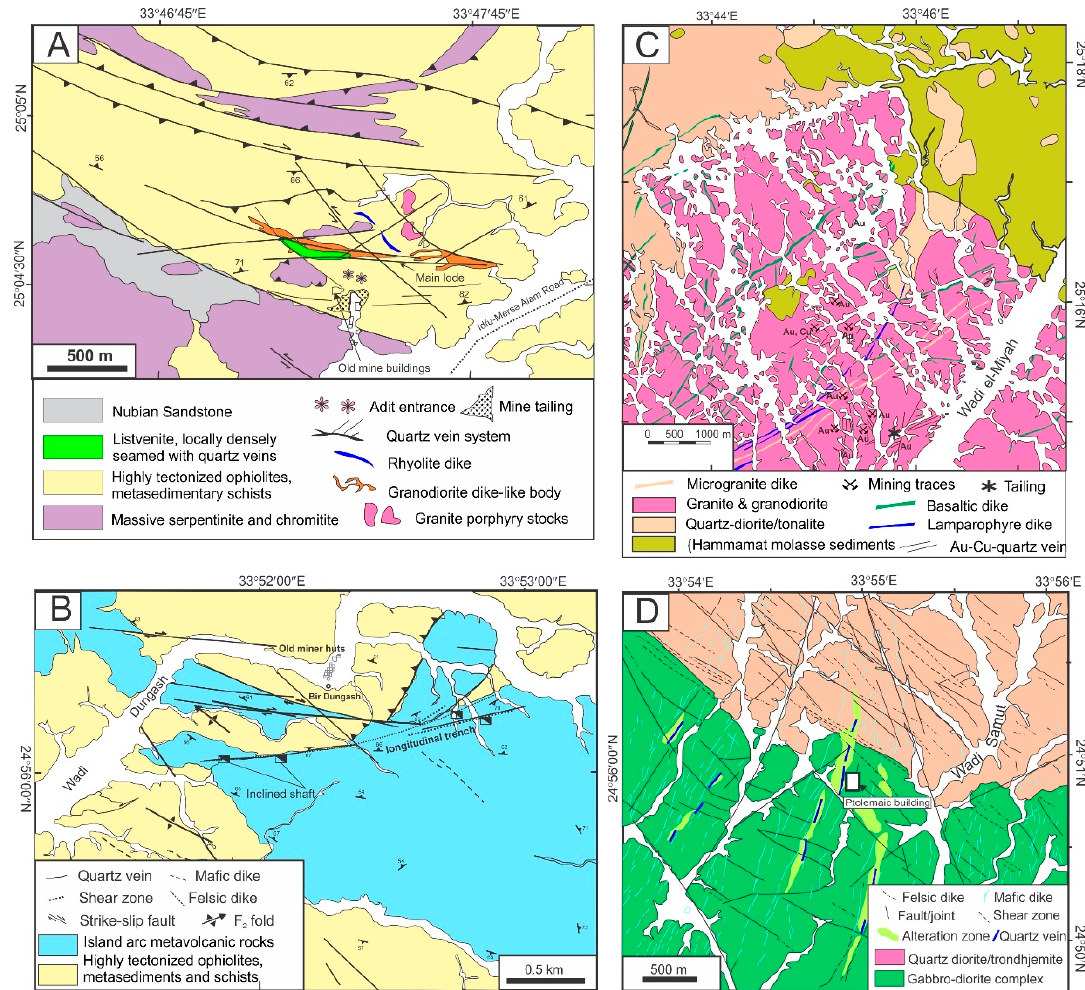
Figure 12. Detailed geological maps of the selected gold occurrences/deposits in the study area, ( A ) Barrmaiya deposit area, after [36], ( B ) Dungash deposit area, after [37], ( C ) Bokari deposit area, after [78], and ( D ) Samut gold deposit area, after [46].